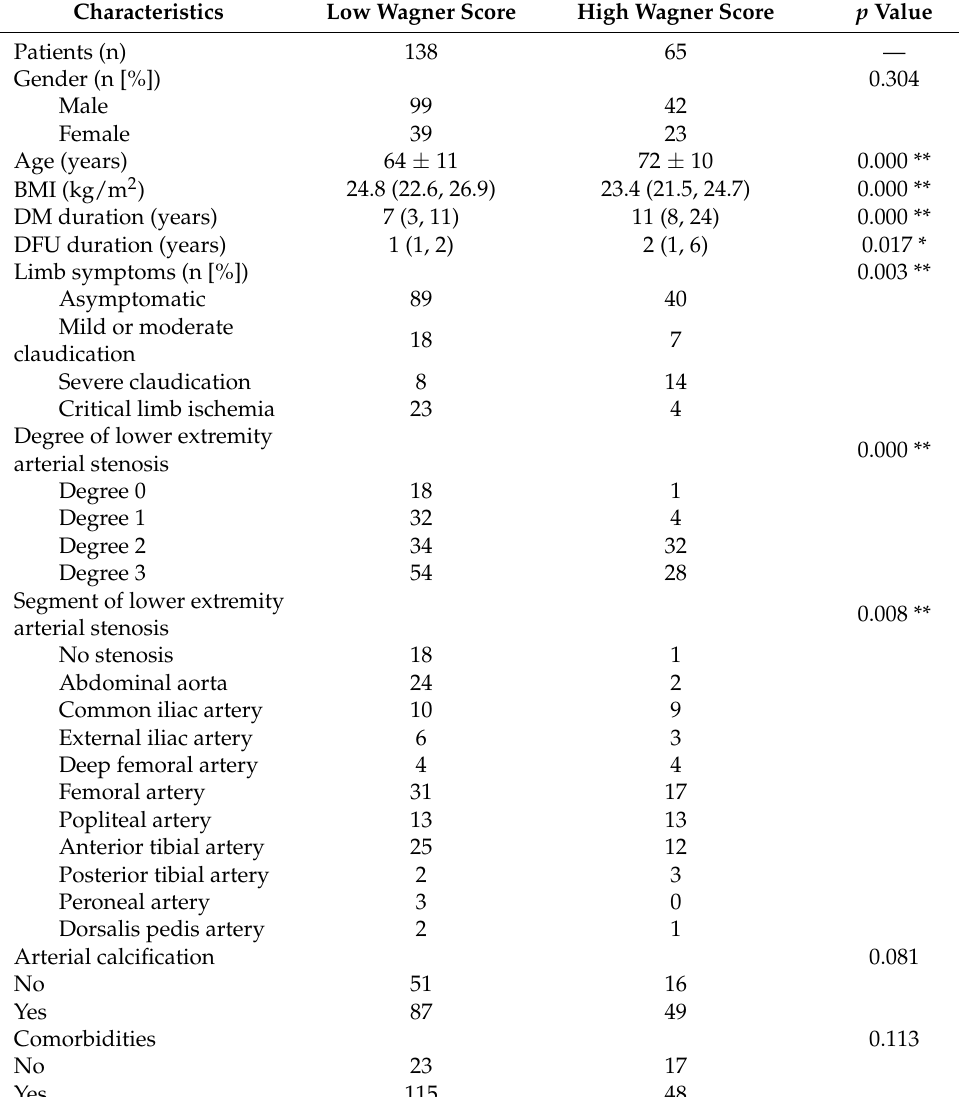
Table 2. Comparison of demographic and clinical characteristics between the low and high Wagner Score